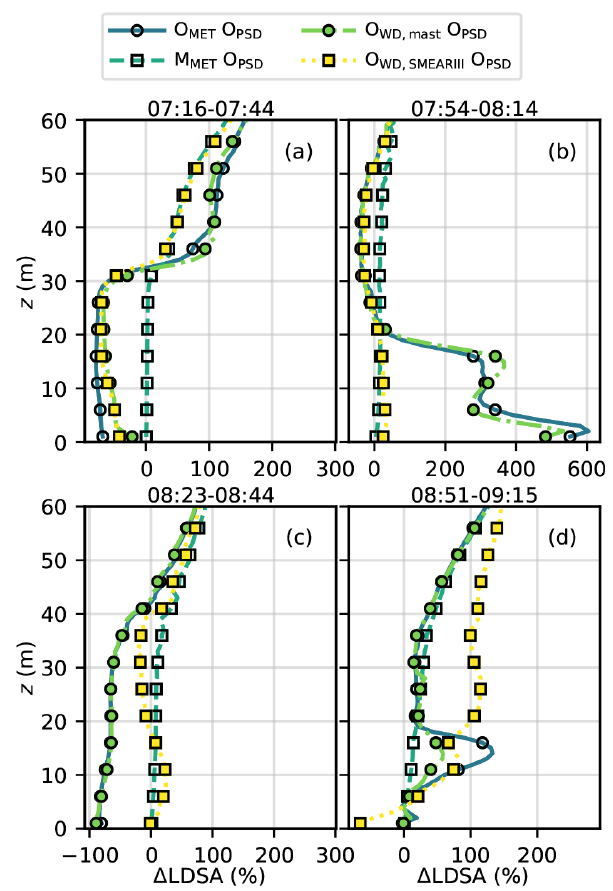
Figure 12. Relative difference in the lung-deposited surface area ( (cid:49) LDSA) of aerosol particles compared to M MET M PSD at the su- persite (a, c) and opposite the supersite (b, d) on the morning of 9 June. The figure shows the difference in the geometric mean for O MET O PSD (solid line with empty circles), M MET O PSD (dashed line with empty squares), O WD , mast O PSD (dash–dot line with filled squares) and O WD , SMEAR O PSD (dotted line with filled